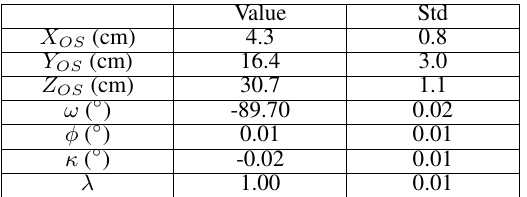
Table 4. Sonar to Optical sensors relative orientation parameters